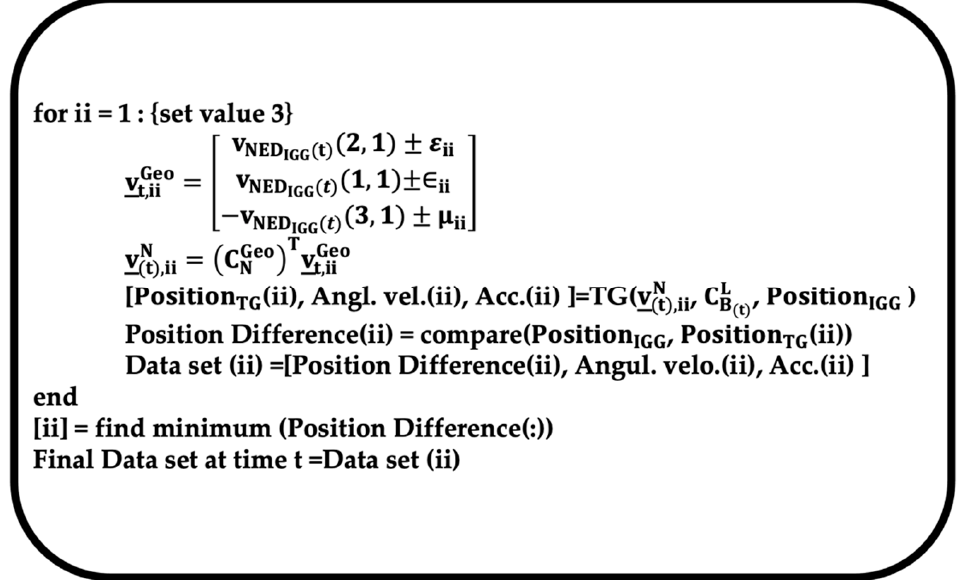
Figure 2. Image of processing program at a particular segment and